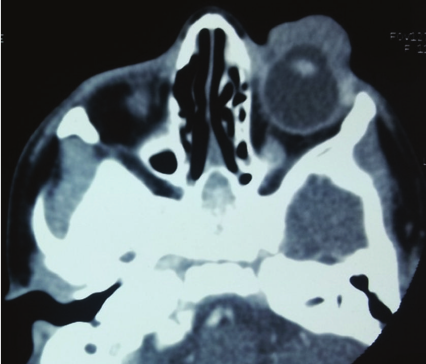
Figure 4: Lobulated soft tissue mass covering the anterior segment of left